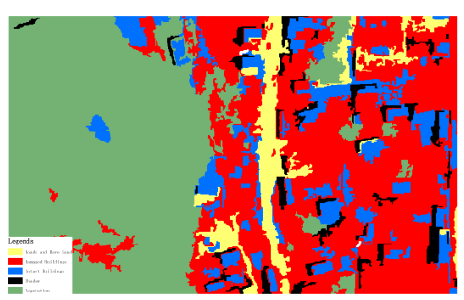
Table 2 Accuracy evaluation of extraction results based on optimal feature space